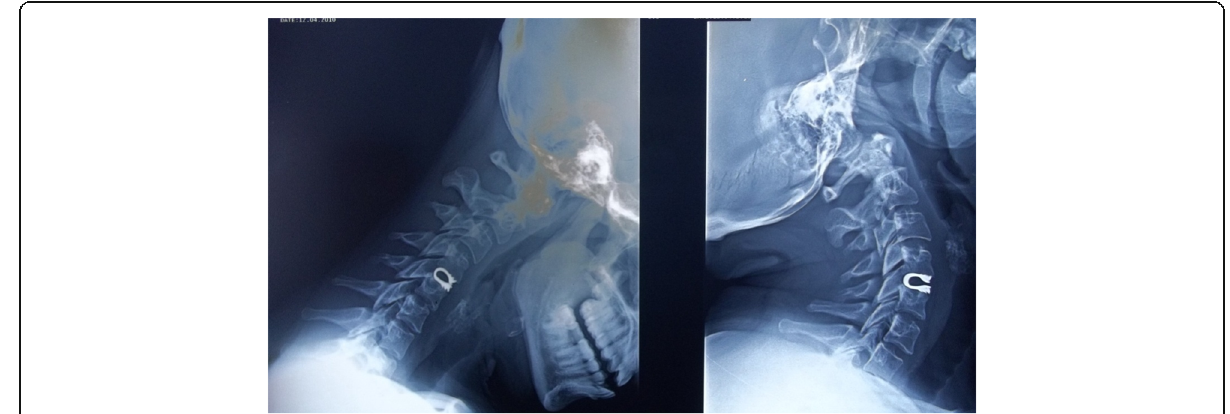
Fig. 8 One month postoperative dynamic cervical plain X-ray